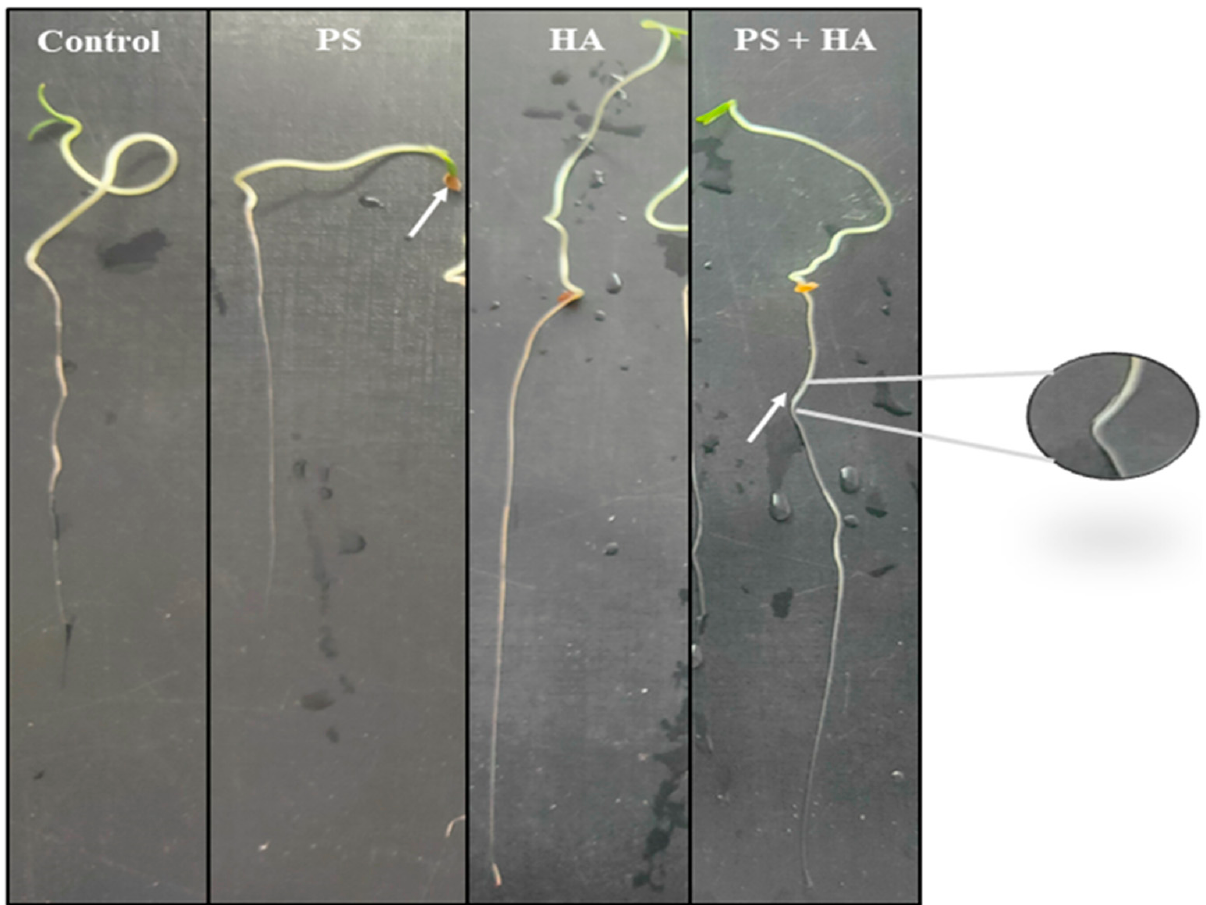
Figure 7. Effect of PS, HA, and PS + HA treatments, as well as control (untreated), on Solanum lycopersicum plant over 9 days. PS showed on the ninth day still leaf not penetrated, control and HA showed full grown plant as well as PS + HA full-grown plant, then secondary root penetration